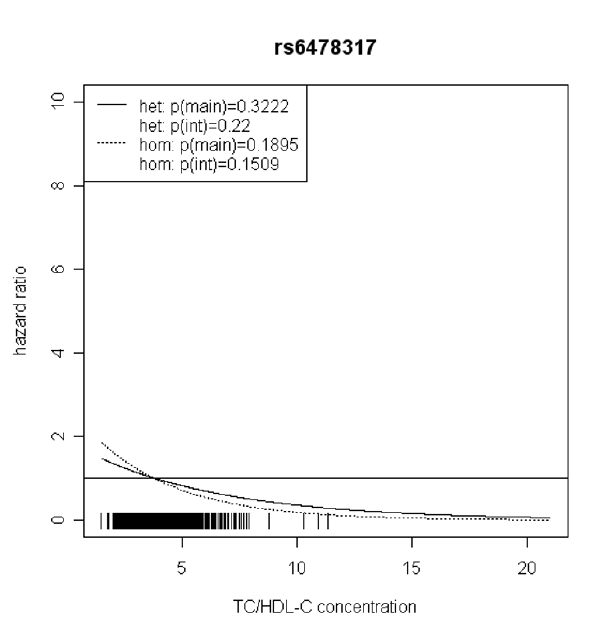
Figure 10 Hazard ratios of incident type 2 diabetes related to the respec- tive TC/HDL-C concentration in women for rs6478317 . Dashed lines represent subjects who are homozygote for the minor allele, while continuous lines show heterozygotes. Small bars at the x-axis indicate TC/ HDL-C concentrations of patients with at least one copy of the minor allele.